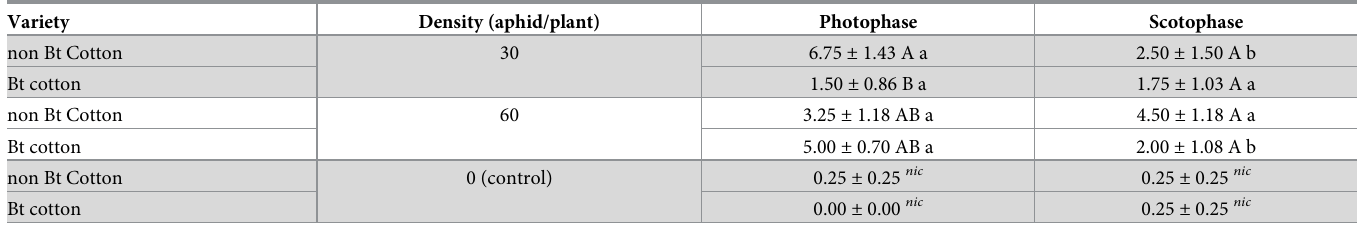
Table 2. Number of variation potentials emitted (mean ± SE) by Bt and non-Bt cotton plants exposed to different aphid densities / cotton plant and photophase and scotophase on the 3rd assessment day.